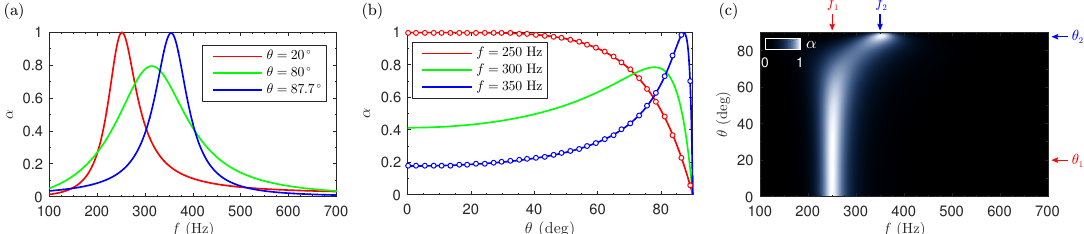
Figure 2. ( a ) Absorption of the metamaterial using N = 1 HR as a function of the frequency for incidence angles θ = 20 ◦ ,80 ◦ ,87.7 ◦ ; ( b ) Angle-dependent absorption obtained using transfer matrix method (TMM; continuous lines) and Equation (10) (circles) at frequencies f = 250,300,350 Hz; ( c ) Map of the absorption as a function of the frequency and incidence